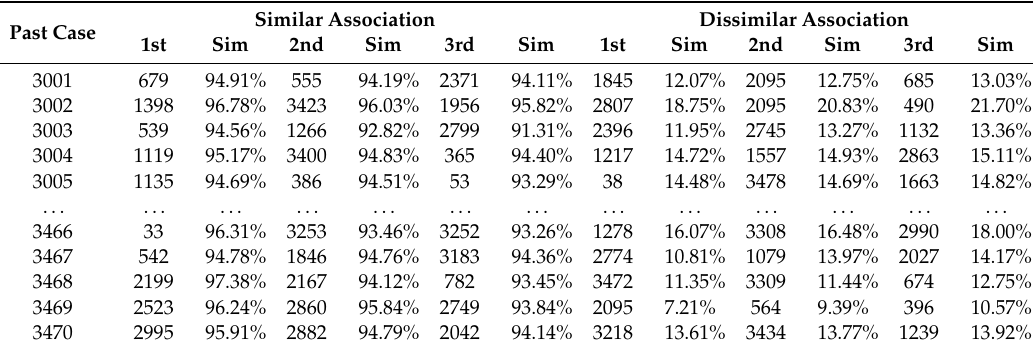
Table 11. Part of the generated association table for newly retained